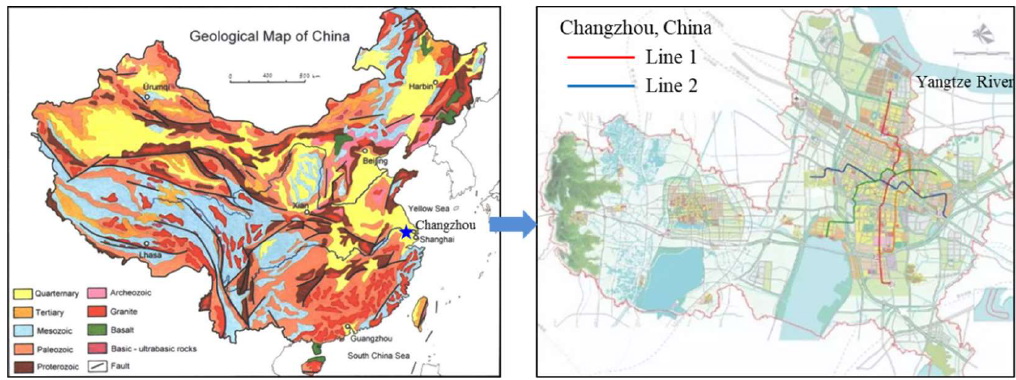
Figure 1. Location and distribution of the rail track system in Changzhou.